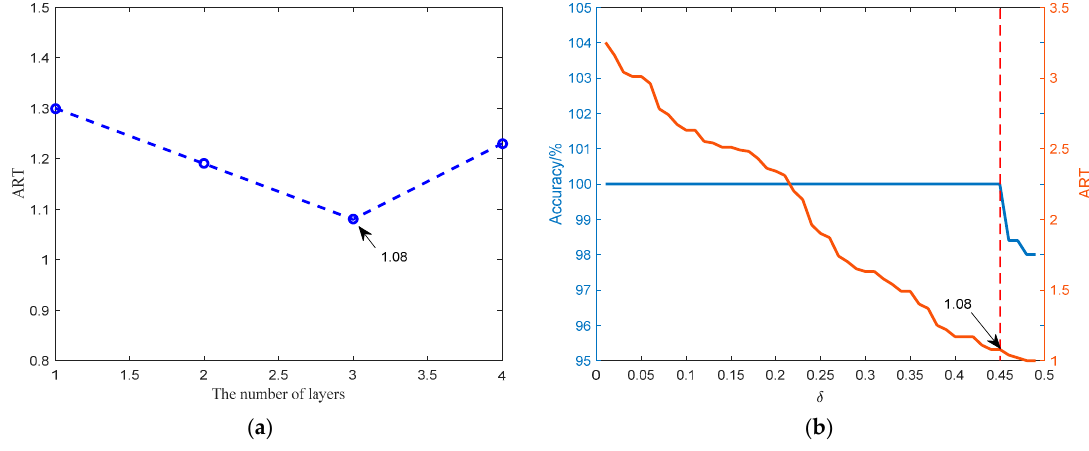
Figure 6. ( a ) The relationship between ART and number of layers; ( b ) δ sensitivity